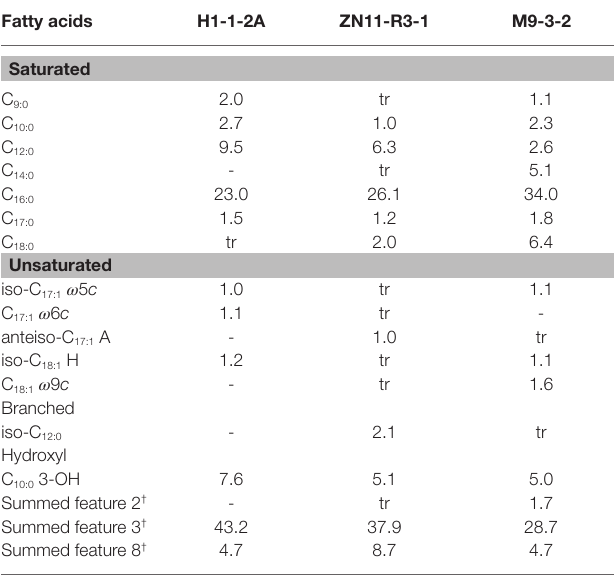
TABLE 2 | Fatty acid profile of strain H1-1-2A T and strain ZN11-R3-1 compared to close relative N. mangrovi M9-3-2 T . Fatty